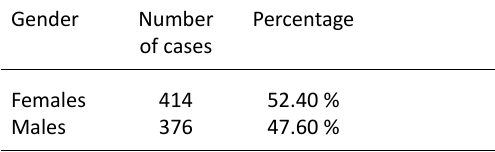
Table 2. Distribution of patients according to gender